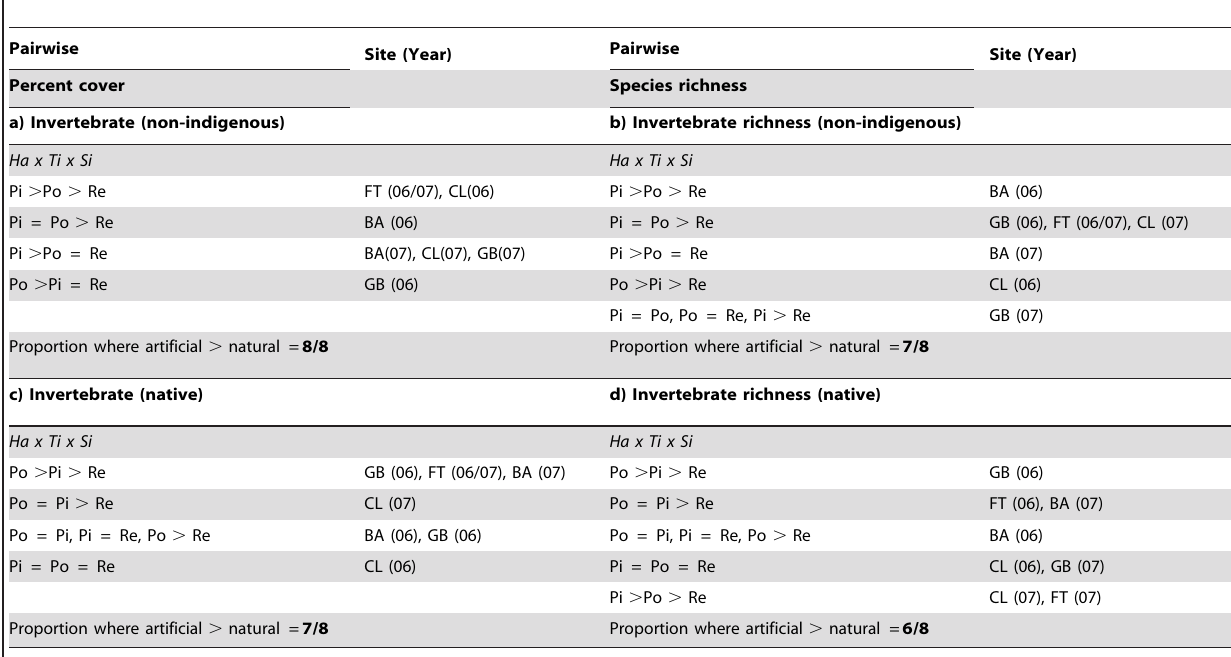
Table 2. Pairwise comparisons of the non-indigenous and native invertebrate species percent cover and richness sampled from artificial and natural